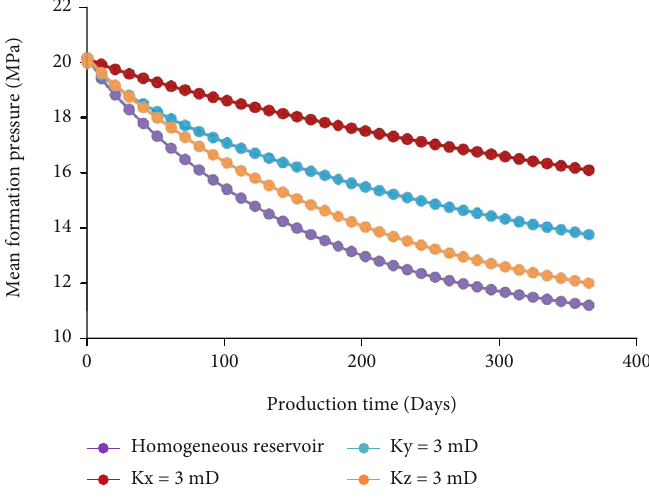
Figure 8: Variation curve for average reservoir